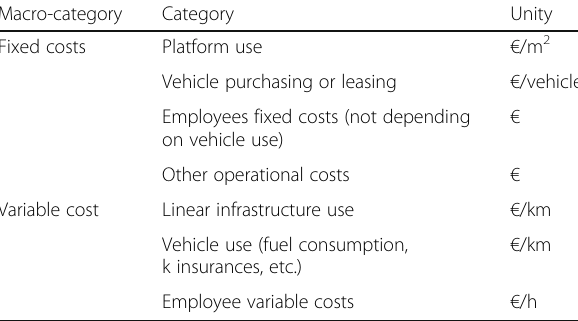
Table 1 Main cost